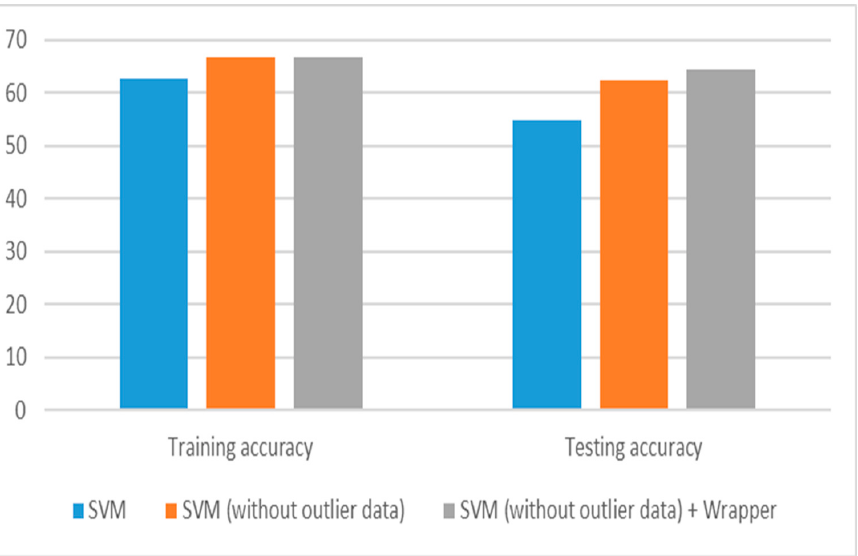
Figure 5. The classification accuracy of the SVM algorithm through the proposed system phases to predict the total recovery cases.